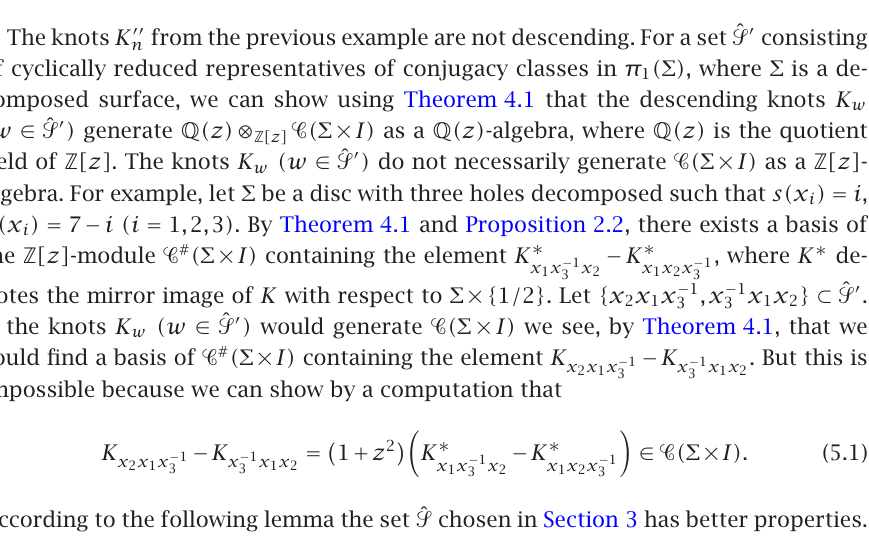
(cid:10) = K (cid:10) − zK (cid:10) ∈ (cid:1) ( Σ × I) − 1 3 3 4 K